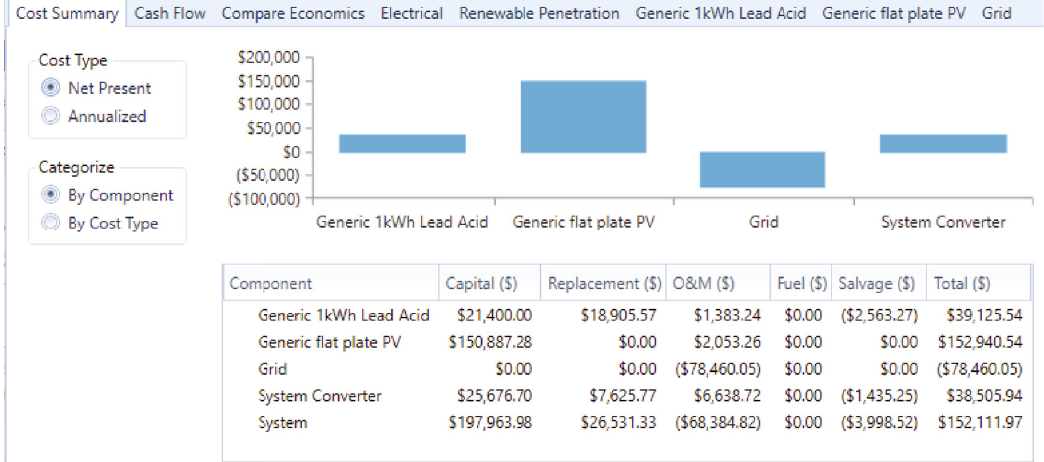
Figure 7: Economic summary of energy proposed system.